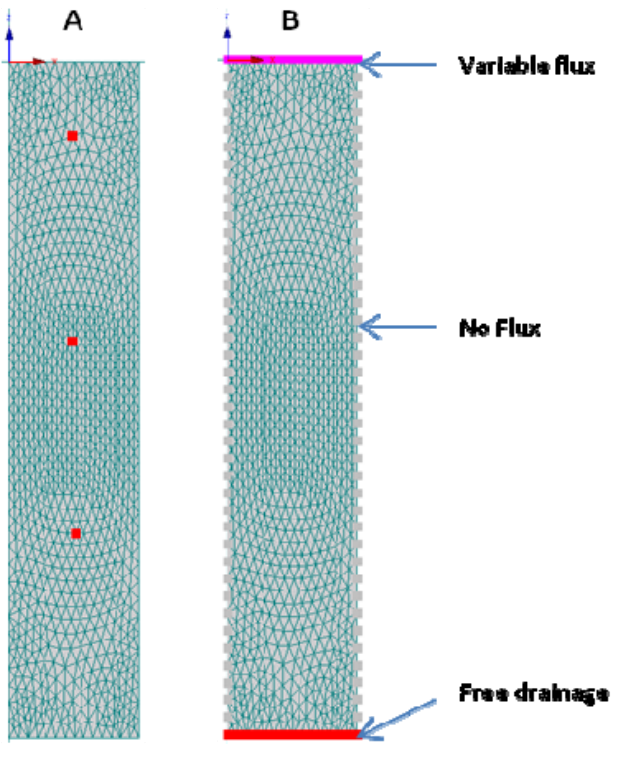
Figure 2. Hydraulic model domain with ( A ) observation nodes at 4 cm, 14 cm and 25 cm depths; ( B ) boundary